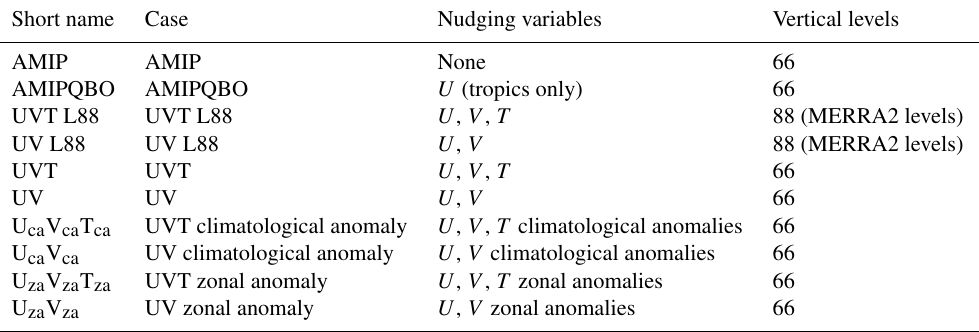
Table 1. Full list of WACCM simulations examined in this study, the MERRA2 variables with which they are nudged, the number of vertical levels, and the short name by which the figures refer to the simulation. See text for further